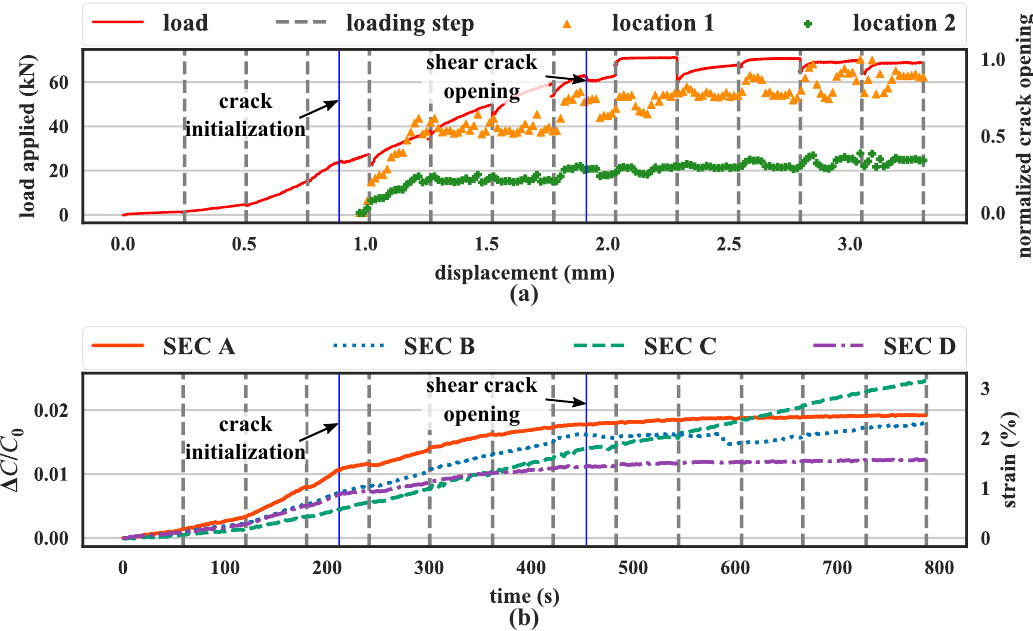
Figure 4. Time series results from the small-scale reinforced concrete beam: ( a ) load-displacement curve and normalized crack opening widths histories; and ( b ) relative capacitance and computed strain histories for all four